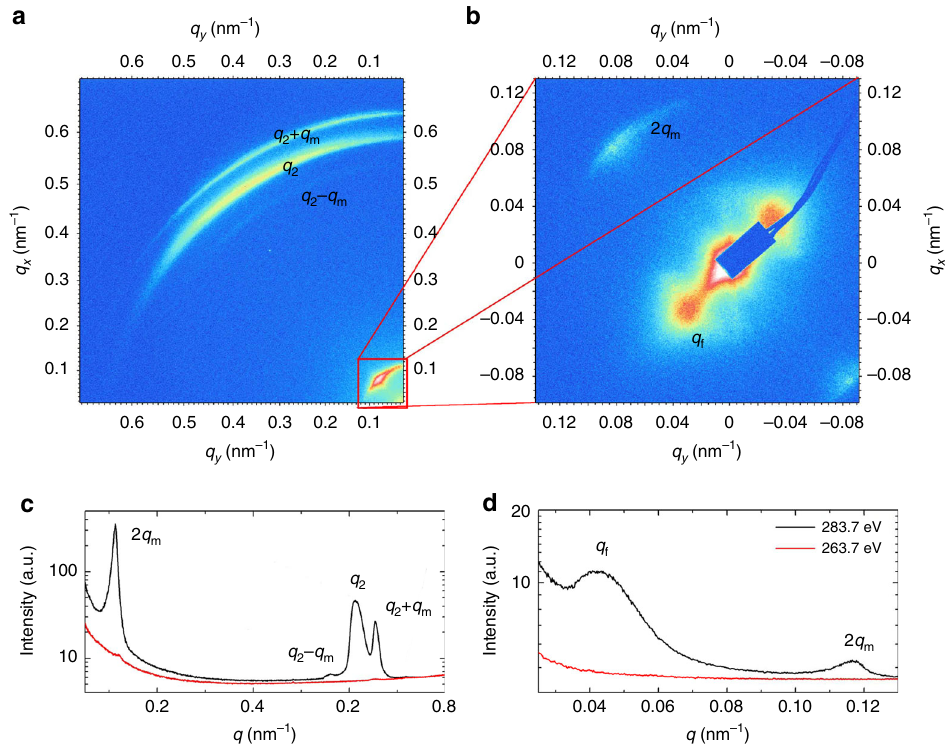
Fig. 4 The resonant soft X-ray scattering for material D2 . 2D RSoXS patterns in the HexI phase registered at 80 °C in a a wide and b small-angle regimes. The signal intensity integrated over an azimuthal angle in c wide and d small-angle range; black line: intensity registered at carbon absorption K-edge, 283.7 eV; red line: intensity registered at off-resonant energy 263.7